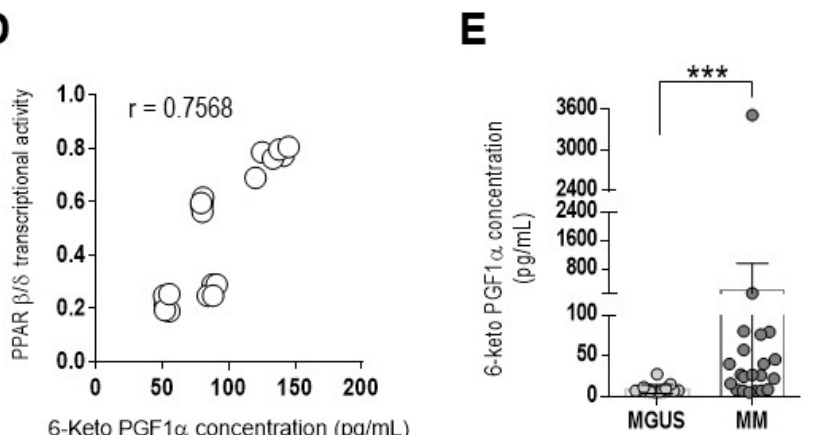
Figure 3. PPAR β / δ soluble endogenous activating ligand 6-keto prostaglandin F1 α (6-keto-PGF1 α ) concentration in cultured cells and serum from MGUS and MM patients. ( A – C ) ELISA determina- tion of the 6-keto-PGF1 α concentration in supernatants from ( A ) MGEC and MMEC, ( B , C ) MMEC cultured for 24 h, alone (CTR) or with RPMI 8226 cells at 1:1 and 1:10 cell ratios and separated ( B ) or not ( C ) by Transwell inserts. The values are expressed as the mean ± SD. * p < 0.05, ** p ≤ 0.01 and *** p ≤ 0.001, Mann–Whitney test. ( D ) Correlation between the 6-keto-PGF1 α concentration and PPAR β / δ transcriptional activity in MMEC according to a Spearman’s rank test. ( E ) ELISA deter- mination of the 6-keto-PGF1 α concentration in the sera from MGUS and MM patients. The values are expressed as the mean ± SD. *** p ≤ 0.001, Mann–Whitney test.